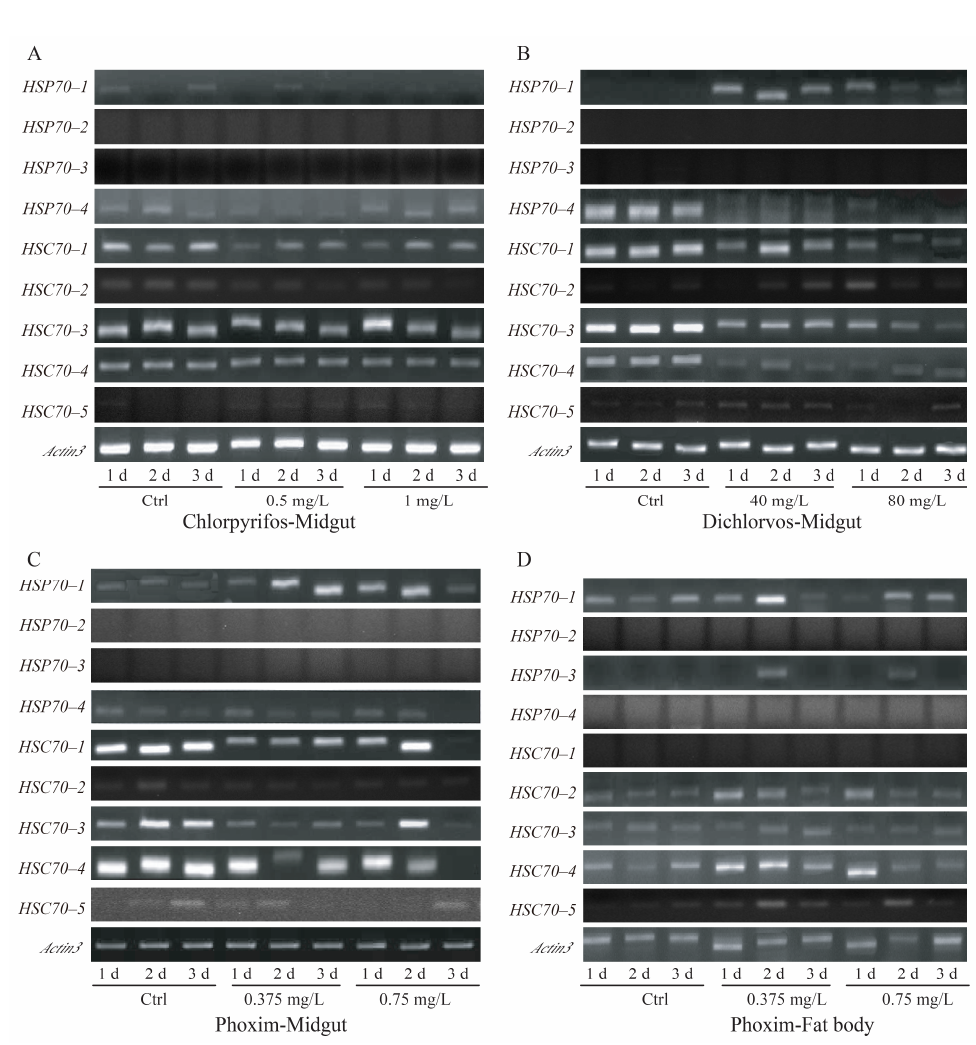
Figure 6. RT-PCR detection of response patterns for HSP70/HSC70 genes in the silkworm after exposure to three OPs. ( A ) Expressions in the midgut of the fifth-instar larvae after chlorpyrifos treatment. Two sub-lethal concentrations (0.5 mg/L and 1 mg/L) were used. ( B ) Responses of HSP70/HSC70 genes in the midgut of the silkworm under dichlorvos exposure. ( C , D ) Effects of phoxim exposure on the expressions of HSP70s/HSC70s in the midgut and fat body. Ctrl: control. The 1 d, 2 d, and 3 d mean 1 day, 2 days, and 3 days under OPs exposure, respectively.